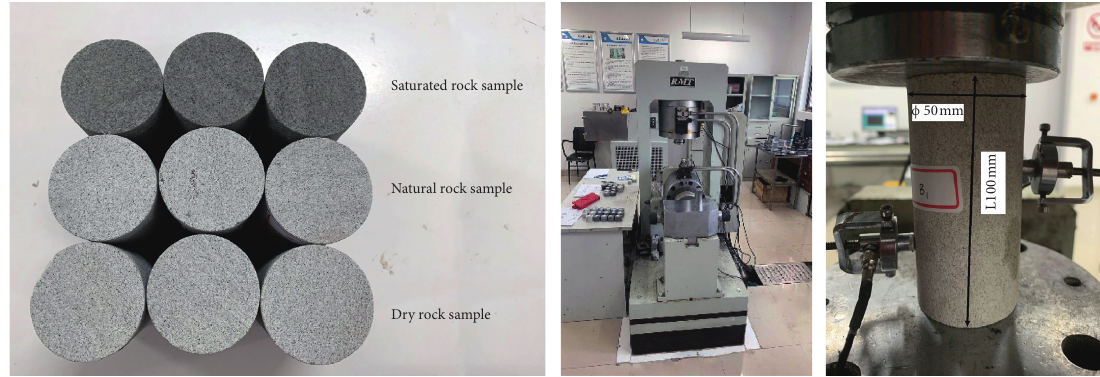
Figure 1: Sample preparation and the test